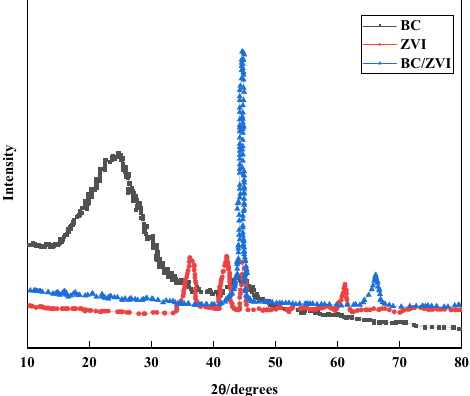
Figure 1. Diffraction results of three BC composites.